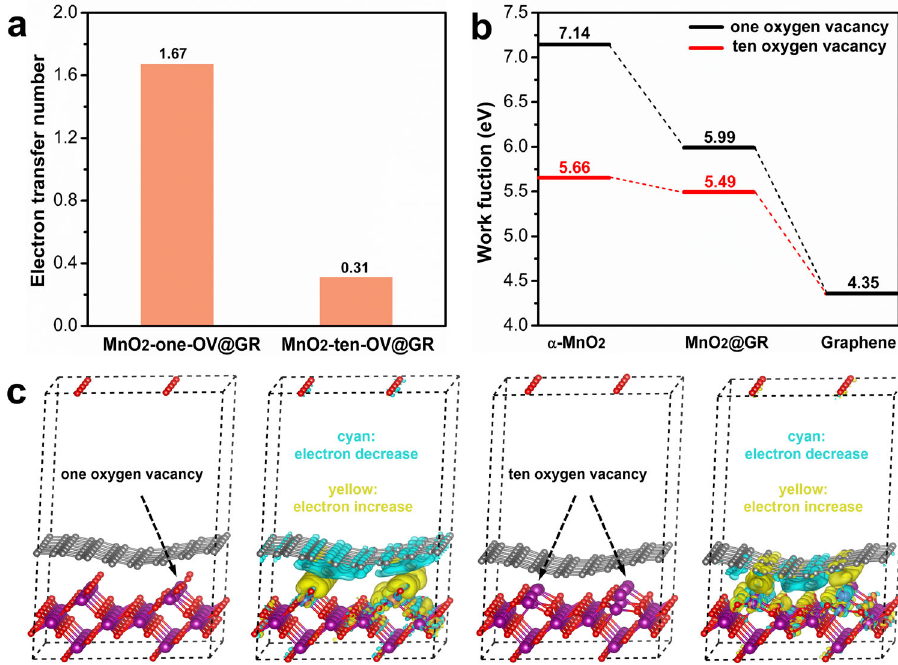
Fig. 6 The local electronic structure in MnO 2 @GR. a The average work function of α -MnO 2 , MnO 2 @GR and pure graphene. b The electron transfer number from graphene to MnO 2 in MnO 2 -one-OV@GR and MnO 2 -ten-OV@GR (electron transfers from graphene layer to MnO 2 ). c The optimised structure of MnO 2 @GR with different oxygen vacancy and their charge-density differences. (The yellow and cyan regions refer to the increased and decreased charge distributions, respectively. The isosurface value of the colour region is 0.001e Å − 3 . The purple, red and grey ball in the models corresponds to the Mn, oxygen and carbon atoms,